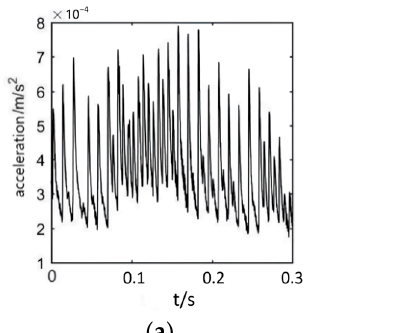
Figure 4. Vibration acceleration curve of the submarine cable. ( a ) Vibration acceleration curve at the moment of anchor smashing; ( b ) vibration acceleration curve at the moment of scouring.